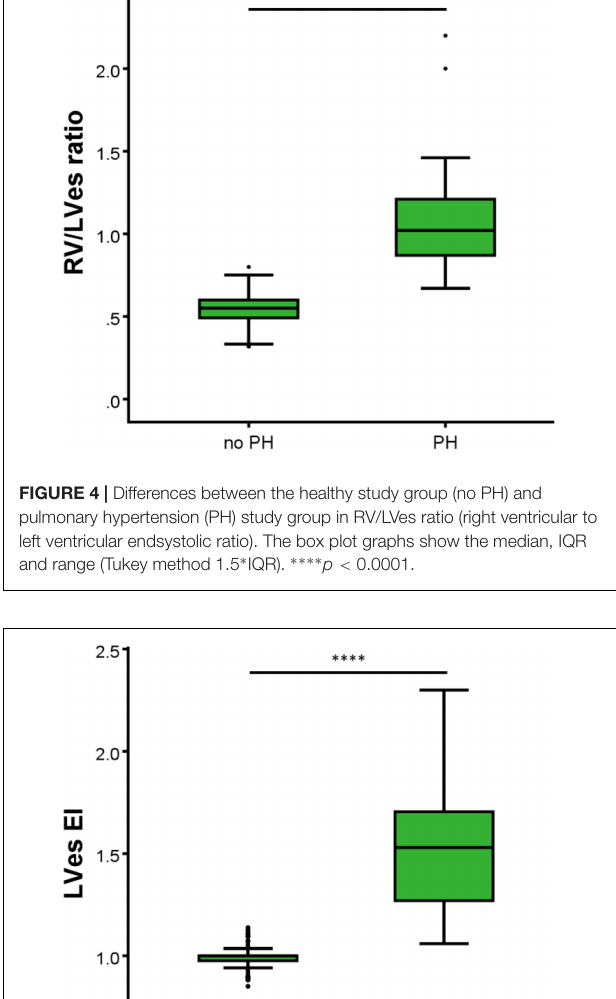
altered RV dimension into account. The RV/LV ratio is